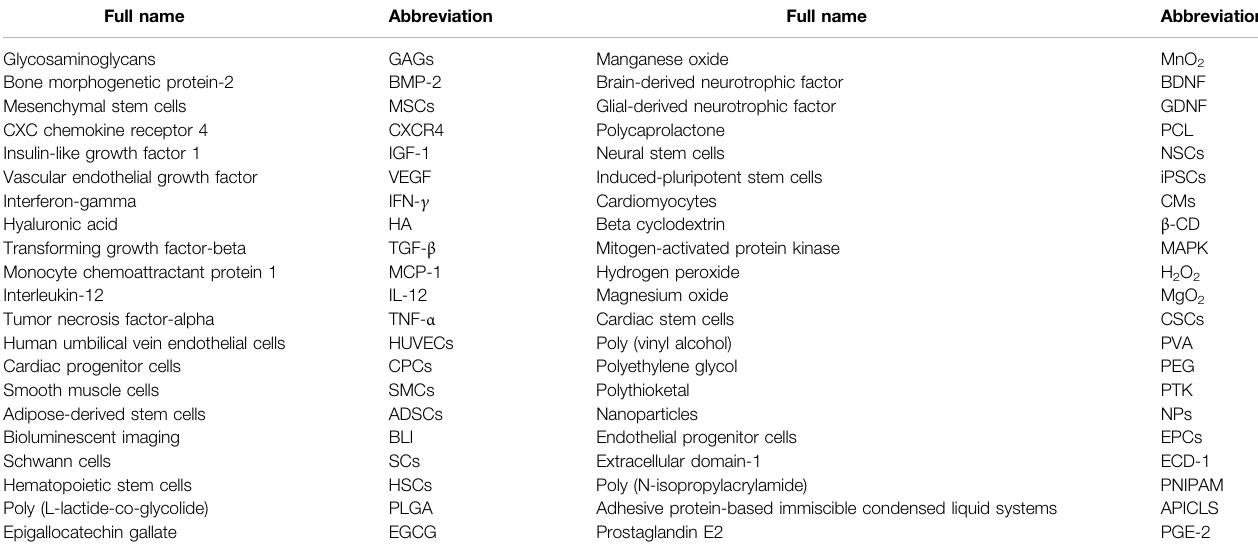
TABLE 1 | List of abbreviations.